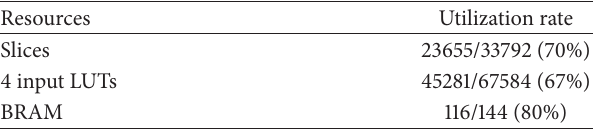
Table 4: The occupancy of